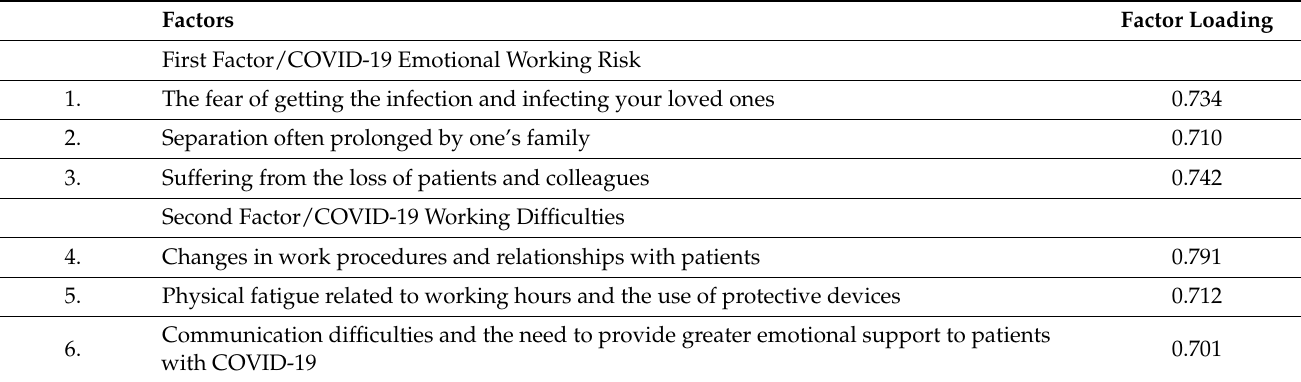
Table 2. Pattern matrix of the PCA for the COVID-19 Risk Factors